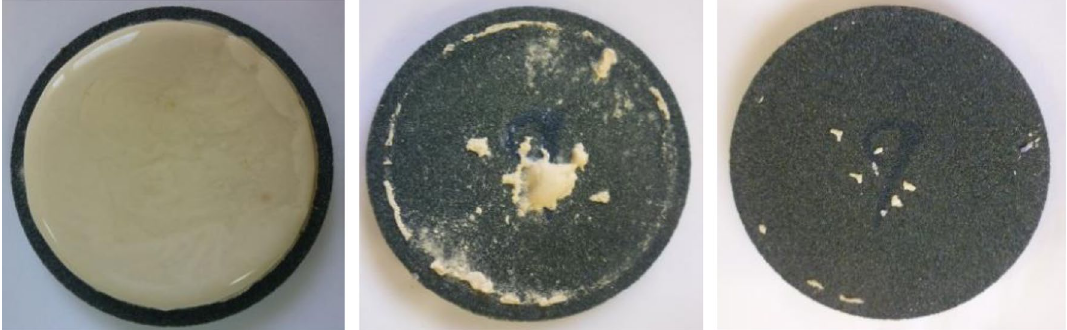
Fig. 6 Demonstration of wellbore cleaning efficiency by the clean-up fluid composition. Initial cake (left); remaining cake after enzyme treat- ment (center); remaining cake after acetic acid treatment